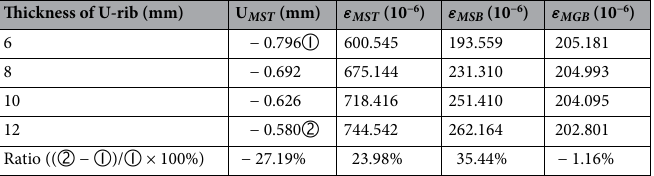
Thickness of U-rib